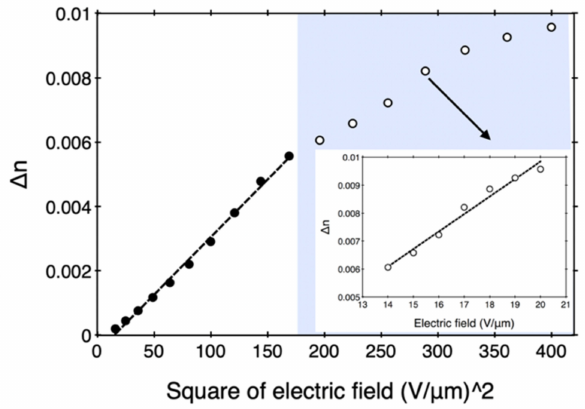
Figure 3. The relation of the induced birefringence and the square of the electric field. The insert shows that in the high applied voltage the induced birefringence depends on the electric field linearly.